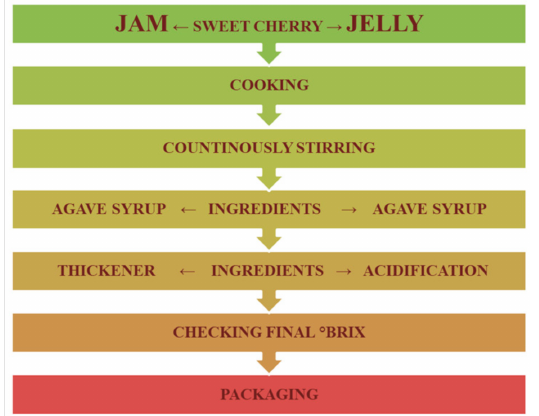
Figure 1. General processing steps for jam and jelly production. As reported in Figure 1, the difference between jam and jelly was the ingredients. In jam, we added pectin or locust bean gum (LBG) as thickener; in jelly, in part of the production we added an aliquot of lemon juice. The experimental design of jam and jelly variables are reported in Table